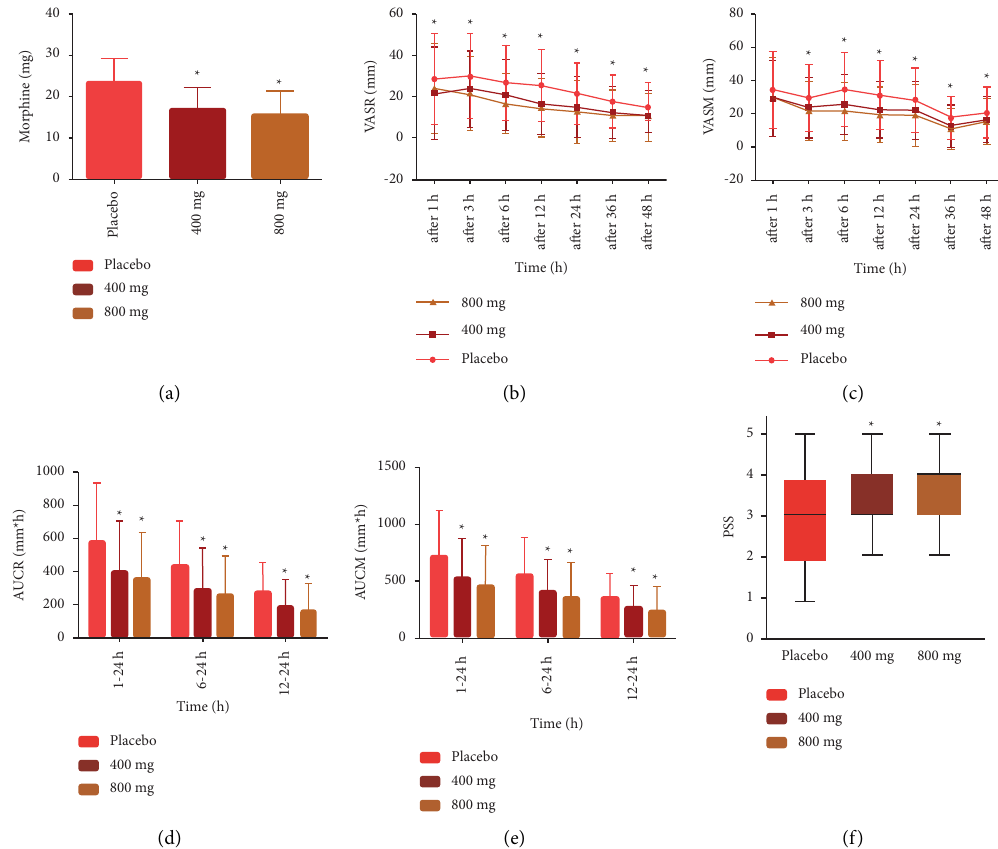
Figure 6: Te efcacy assessment of IVIB during 48h postoperatively. (a) Morphine dose during the 24h postoperative administration. (b) VAS at rest. (c) VAS at movement. (d) Te AUCs of VAS at rest (mm ∗ h). (e) Te AUCs of VAS at movement (mm ∗ h). (f) PSS for pain treatment during hospitalization (PSS was assessed by a 5-point Likert scale: excellent-5;good-4;moderate-3;pass-2; and no pass-1; the bar represents satisfaction score, the bold bar represents the median, the upper and lower limit represent the highest and lowest score, re- spectively) ∗ P < 0.05, vs. placebo (including IVIB 400mg vs placebo; IVIB 800mg vs placebo). VAS, visual analog scale; VASR, visual analog scale at rest; VASM, visual analog scale with movement. AUCR, the area under the curve of VAS at rest; AUCM, the area under the curve of VAS at movement; PSS, patient satisfaction scores; h,